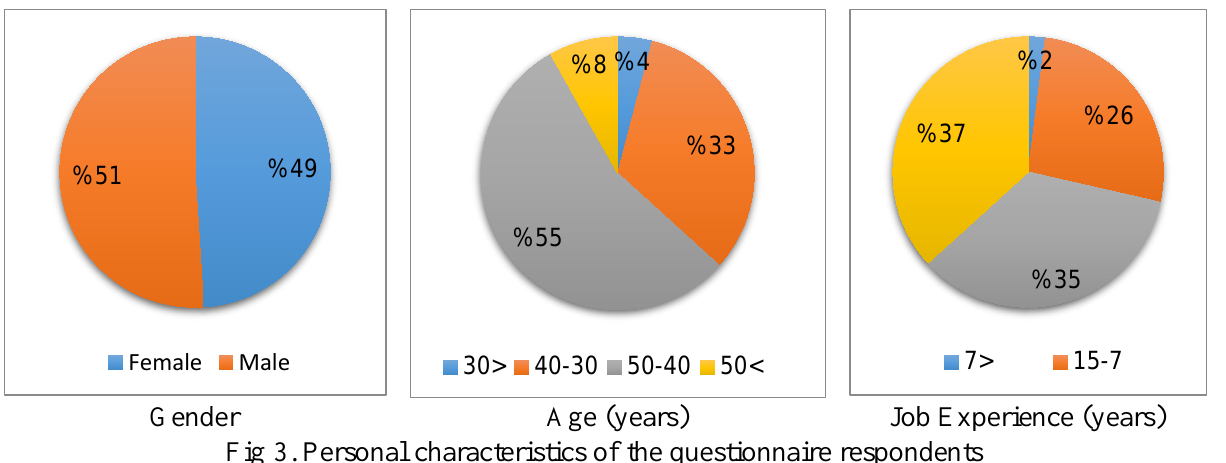
Fig 3. Personal characteristics of the questionnaire